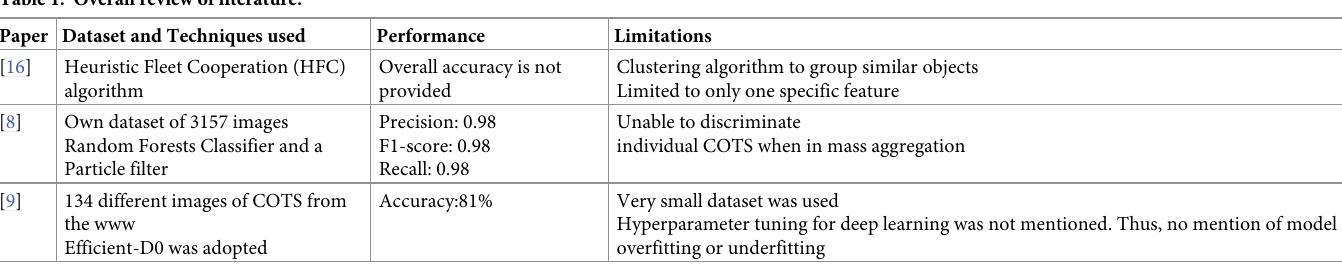
Table 1. Overall review of literature.